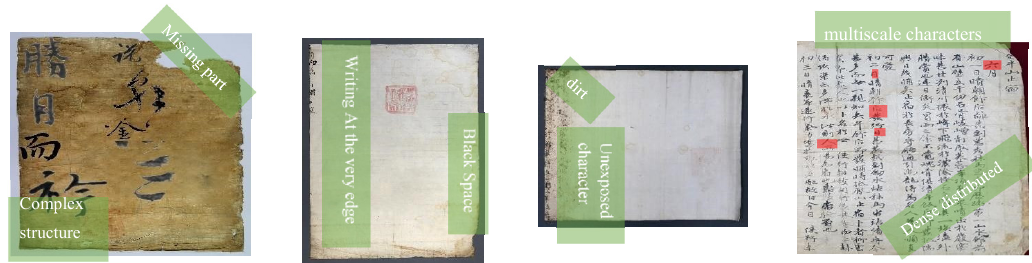
Figure 1. The challenges of handwritten Chinese character detection in old documents.